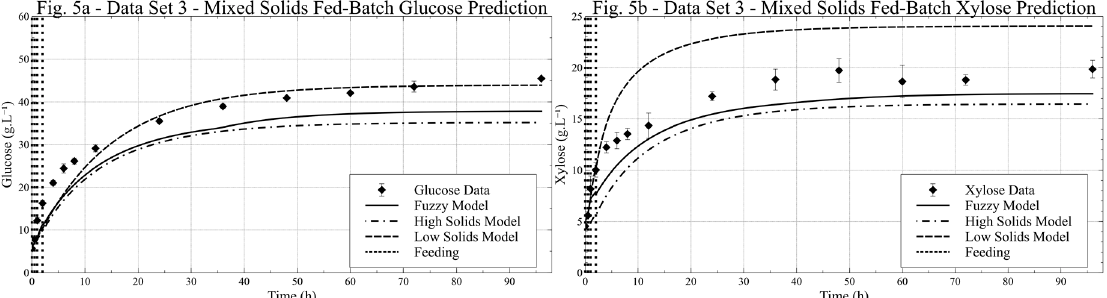
Figure 5. Fuzzy mode, high solids model and low solids model validation data prediction—( a ) Models